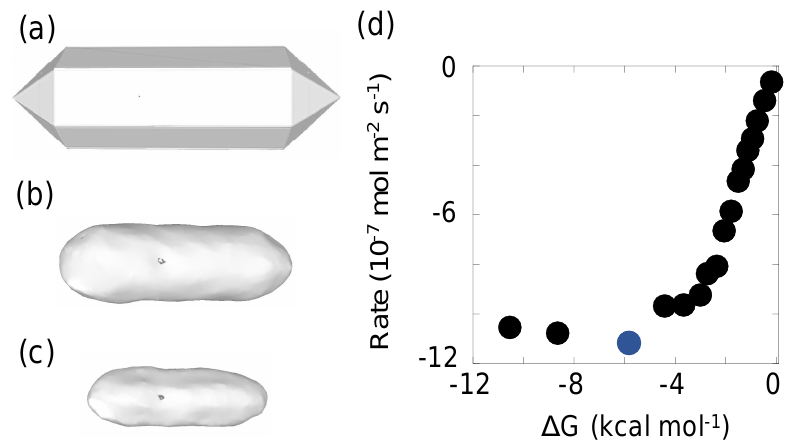
Figure 6. Quartz wulff shape dissolution study with ∆ G . ( a ) Initial state. ( b ) Wulff shape after half of the forming atoms have dissolved. ( c ) 25% of the atoms remain. ( d ) Dissolution rate versus ∆ G curve. Blue point corresponds to the simulation of the topographies in ( a – c ), though similar topographies are obtained in any other point. The visual representation is done using OVITO